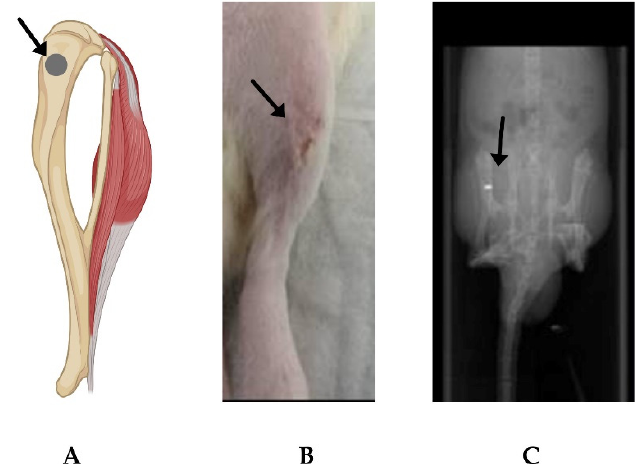
Figure 5. Site of implantation on the animal. ( A ) Diagrammatic representation of the implantation site (arrow) at rat tibia (Created using Biorender.com, accessed on 19 December 2022). ( B ) Representative post-operative image of an animal. ( C ) Representative µCT scout view image for quality control to confirm the implantation site.